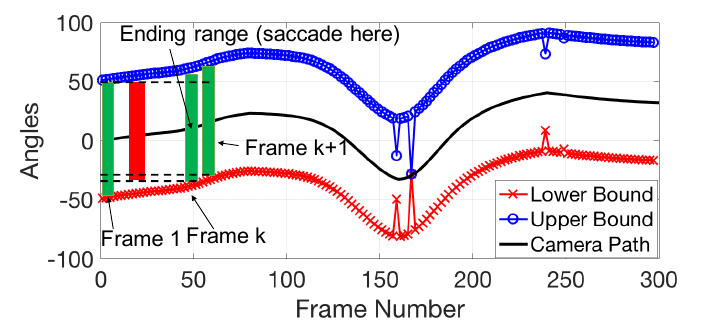
Figure 5. Example of ˜ B ( k )